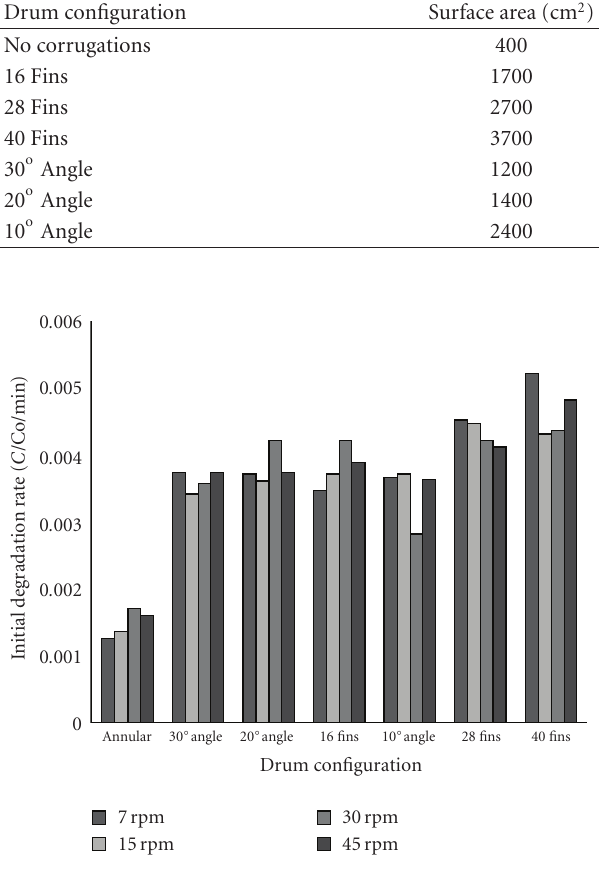
Figure 3: E ff ect of drum configuration and surface area on initial degradation rate.